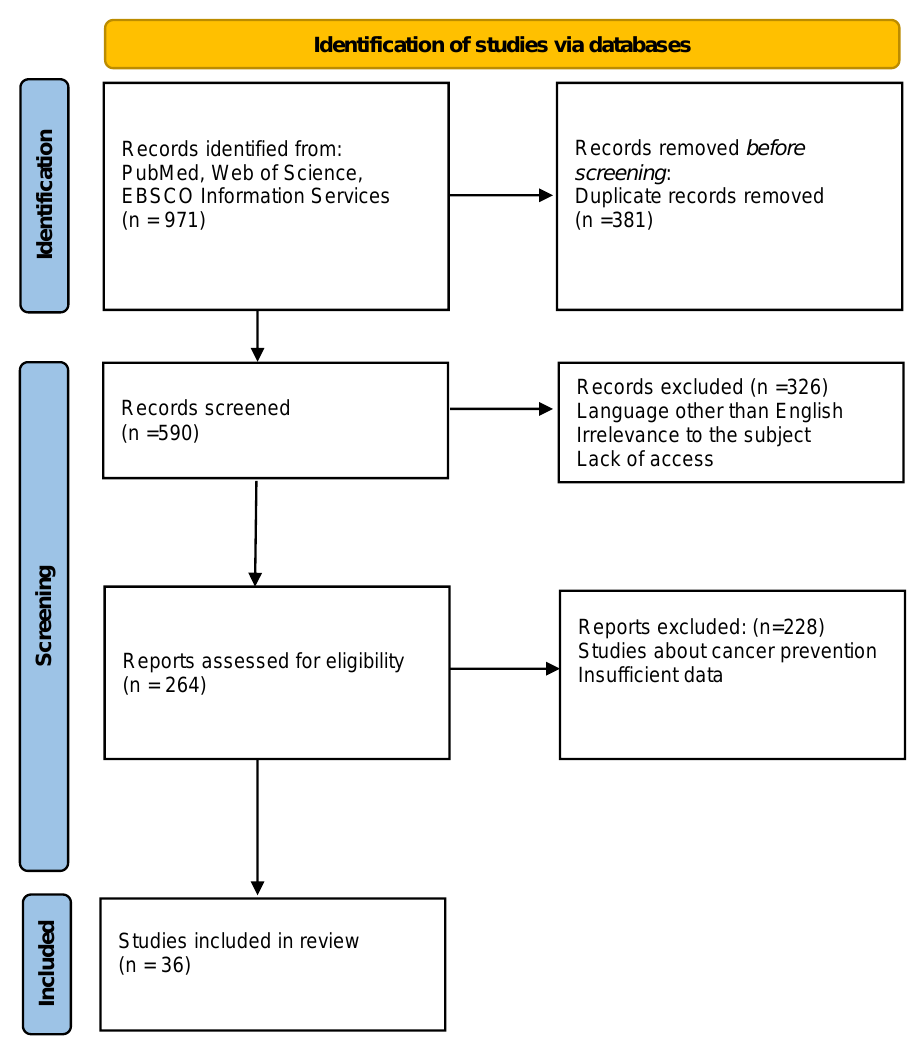
Figure 1. Identification of studies via databases.